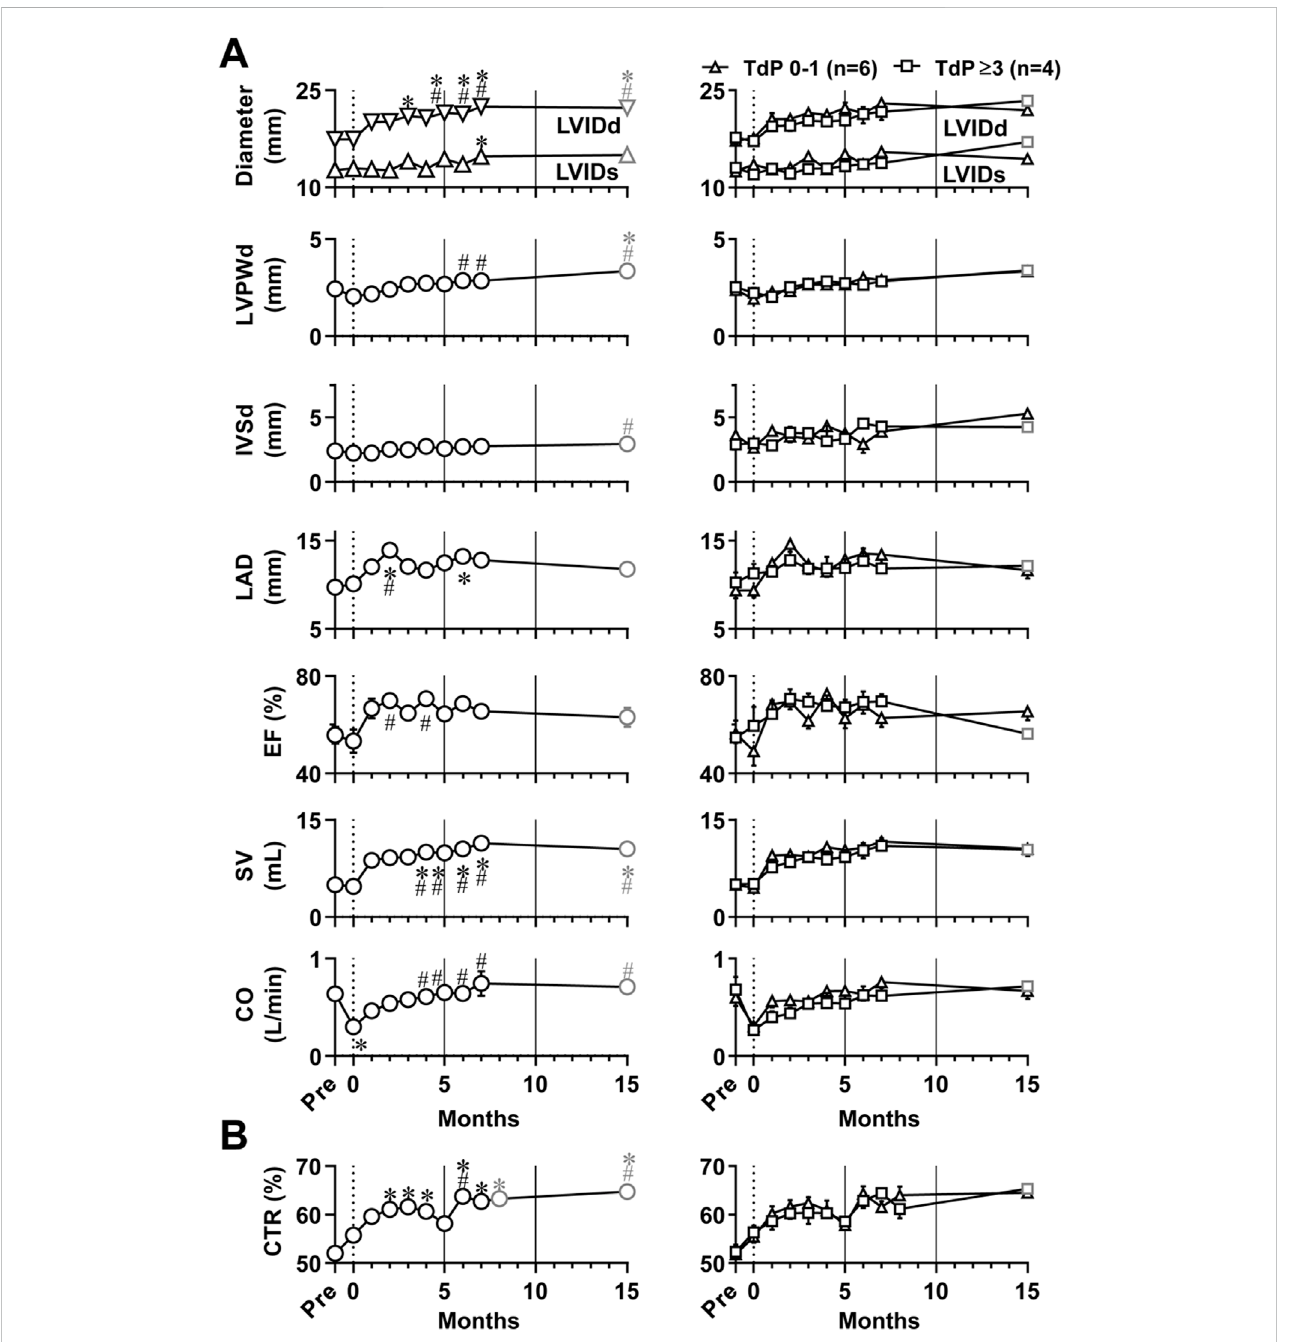
FIGURE 2 Timecoursesofchangesinechocardiographicvariables (A) andcardiothoracicratio(CTR)ofchestradiographs (B) intheatrioventricularblockmonkeys under anesthesia. The basal values(Pre) for the blood pressure,lead II electrocardiogram and chest radiographs were obtained 1 week before the production of atrioventricular block, whereas echocardiography was done just before the surgery for evaluation of Pre (Table 1). * p < .05 vs. Pre; # p < .05 vs. just after atrioventricular block (0 month) by Friedman test with Dunn ’ s multiple comparison test. In the left of each panel, mean values of all animals are shown (black symbols, n = 10 for Pre and 0 – 7 months; and gray symbols, n = 8 at 15 months); and in the right of it, averaged values in animals exerting torsade de pointes 0 – 1 time (TdP 0 – 1, triangles, n = 6) and those exhibiting torsade de pointes ≥ 3 times (TdP ≥ 3, black squares, n = 4 for Pre to 7 months; and gray squares, n =2at15 months)by dl -sotalolchallengearedepicted.Dataarepresentedasmean±s.e.m.LVIDd,leftventricularinternaldiameteratend-diastole; LVIDs,leftventricularinternaldiameteratend-systole;LVPWd,leftventricularposteriorwallthicknessatend-diastole;IVSd,interventricularseptumthickness at end-diastole; LAD, left atrial diameter; EF, ejection fraction; SV, stroke volume; and CO, cardiac